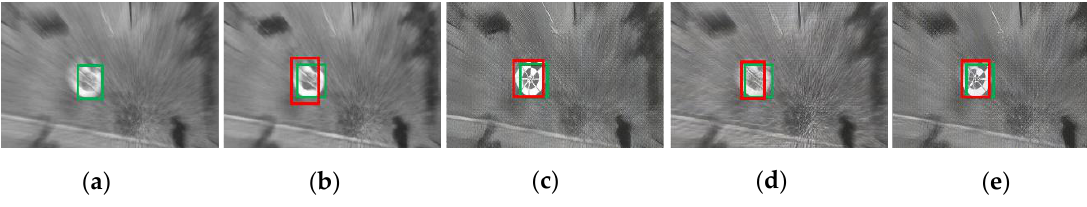
Figure 15. Marker detection results on RMBD-DB1 for five methods at different IoU thresholds: ( a ) precision, ( b ) recall, and ( c ) F1 score.